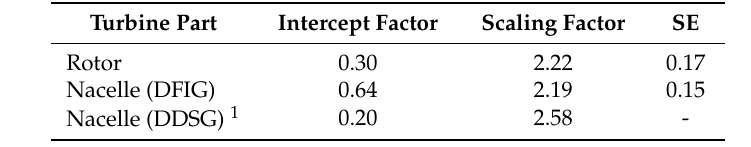
Table 1. Intercept and scaling factors used in Equation (2) to calculate the mass of different turbine parts. Standard error (SE) is presented to show the precision of each calculation. DFIG: Doubly-fed induction generator; DDSG: Direct drive synchronous